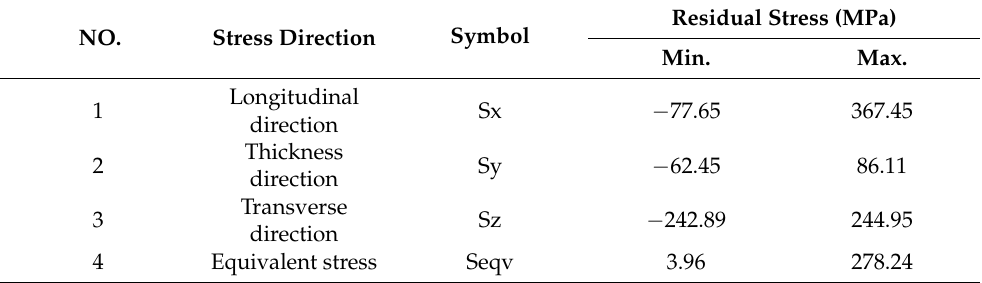
Table 3. Maximum and minimum values of residual stress.